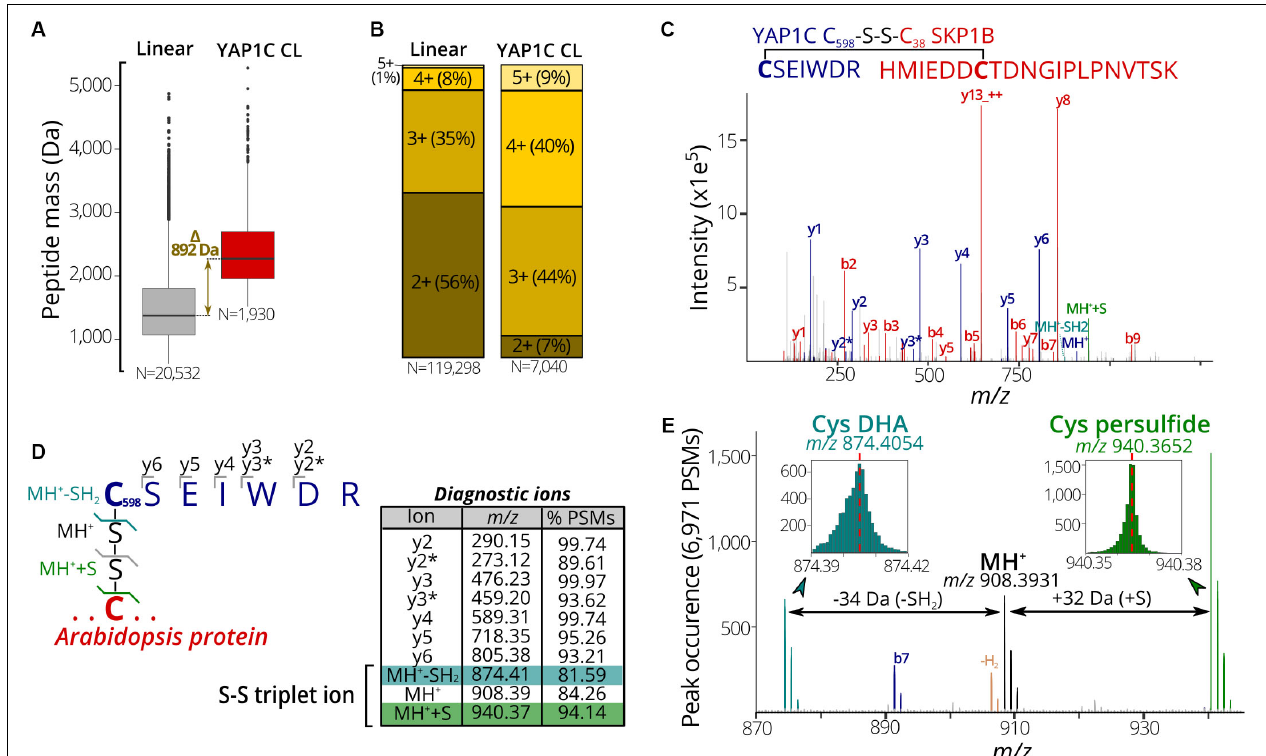
FIGURE 3 | Characteristic properties and fragmentation ions of C 598 SEIWDR CL peptides. (A) Mass distribution for non-redundant linear (left) and C 598 SEIWDR CL peptides (right). A 892-Da difference is indicated between the median peptide masses of both distributions. (B) Peptide precursor charge distribution for PSMs to linear and C 598 SEIWDR CL peptides. (C) Annotated spectrum of C#SEIWDR CL (blue fragment ions) to HMIEDDC#TDNGIPLPNVTSK (red fragment ions). (D) Parsing of 6,971 PSMs of the YAP1C cross-links (FDR ≤ 1%) containing at least five C 598 SEIWDR b, y, or precursor ions (within m/z 0.01) for diagnostic ions. To this end, the occurrence of a peak was counted at a m/z 0.001 interval (irrespective of its intensity) to identify consistent fragment ions. Ten characteristic C 598 SEIWDR CL peptide ions were displayed in the peptide fragmentation scheme and table, with y2* and y3* indicating an ammonia neutral loss (-NH 3 ). A triplet ion resulting from disulfide fragmentation patterns is highlighted. (E) Occurrence of triplet ion peaks characteristic of disulfide cleavage in 6,971 PSMs of C 598 SEIWDR CL peptides (FDR ≤ 1%, ≥ 5 fragment ions). The expected C 598 SEIWDR precursor mass is indicated in black ( m/z 908.3931) and is flanked by Cys dehydroalanine (DHA, blue; m/z 874.4054) and Cys persulfide (green; m/z 970.3652). Brown peaks correspond to the MH+ precursor minus two